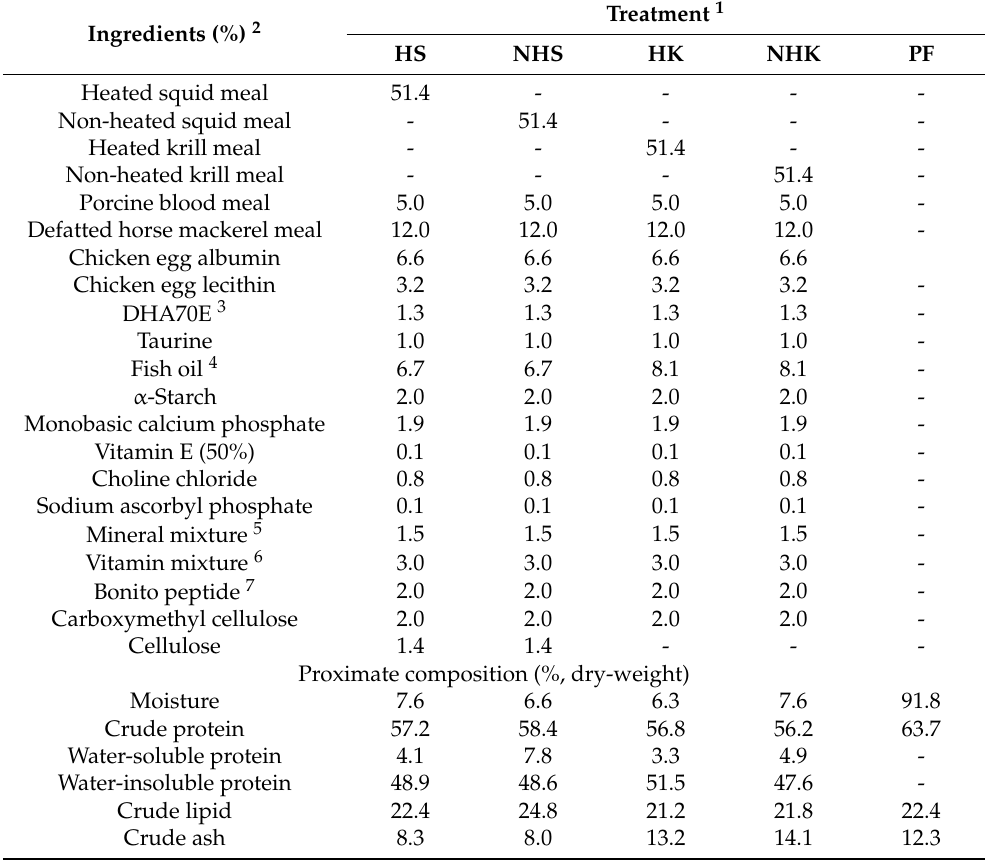
Table 1. Formula, proximate composition, and water-soluble and -insoluble protein content in the test